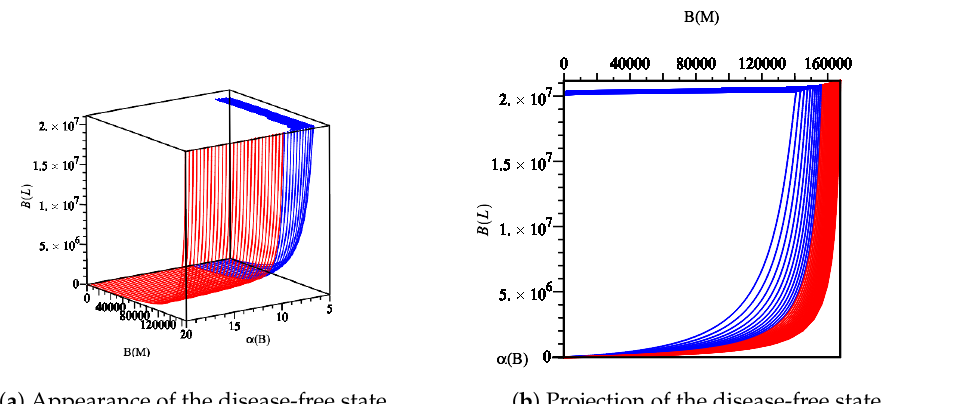
Figure 11. Diagram displaying the disease-free state by fixing the parameter values Ye SPF wt/A0 from Table 3 in Model (14). As long as α ( B ) is large enough, the disease-free state persists. However, by reducing α ( B ) , the basic reproduction number R wt changes in the dynamic behavior of the model (14), as shown in Figure